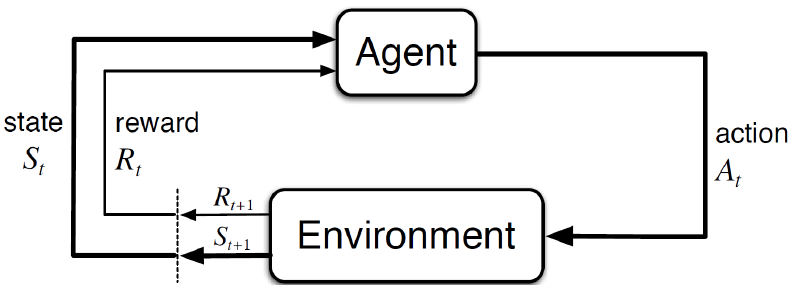
Figure 2. Reinforcement learning agents: An RL agent is situated in an environment composed of a finite or infinite number of states. Given the state S t with a reward R t , the RL agent chooses an action A t that maximizes the cumulative rewards. Taking the action A t leads the RL agent to the new state S t + 1 with a new reward R t + 1 . After evaluating the effect of the previous action A t given the new state S t + 1 , the RL agent repeats such a cycle iteratively in order to achieve a goal in the environment. (Copyright © Sutton and Barto (1998). This figure was taken from